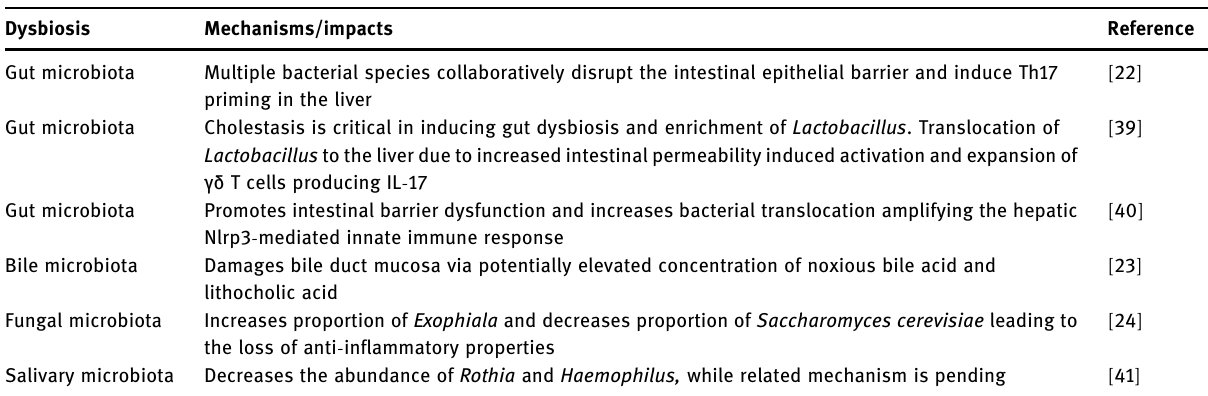
Table 1: Recent reports on mechanisms of microbiota in PSC Dysbiosis